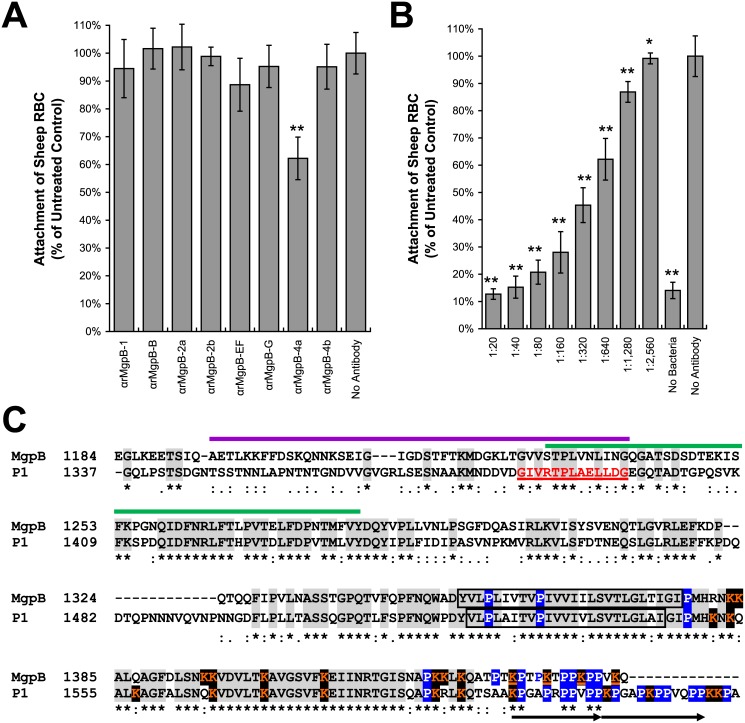
Attachment domains within MgpB are Located within the Proximal Conserved C-terminus and Share Homology with the Attachment Domain of the M. pneumoniae P1 Protein.(A) The results of the quantitative hemadsorption inhibition assay showing that antibodies reacting with the proximal conserved C-terminus (α-rMgpB-4a) diluted 1:640 inhibit hemadsorption by approximately 40% (**, p < 0.0001). At dilutions with comparable reactivity to MgpB (1:20, α-rMgpB-2b and-EF; 1:40, α-rMgpB-2a and-G; 1:80, α-rMgpB-1 and -4b; 1:320 α-rMgpB-B), antibodies reacting with other regions of MgpB have no statistical impact on the binding of red blood cells with results similar to untreated control wells not pretreated with antibodies. (B) Hemadsorption inhibition experiments demonstrating the inhibitory effect of α-rMgpB-4a antibodies was dose dependent; two-fold dilutions of this antibody ranging between 1:20 and 1:1,280 significantly decrease hemadsorption (**, p < 0.0001; *, p = 0.007) with lower dilutions completely inhibiting the binding of red blood cells with results comparable to the no bacteria control wells. In panels A and C, error bars represent standard deviation. (C) Alignment of the proximal and distal conserved C-termini of MgpB (aa 1,184–1,444) with the C-terminus of the homologous P1 adhesin (aa 1,337–1,627) of M. pneumoniae, for which the attachment domain has also been defined. Within P1, the location of peptides 7 and 8 [48] are noted with purple and green lines, respectively, and the binding epitope for the attachment inhibiting monoclonal antibody [49] (designated PepD) is underlined in red. Amino acids identically conserved between MgpB and P1 are highlighted in gray; additionally, predicted transmembrane domains predicted by TMHMM are boxed and the location of cytoplasmic proline (white/blue) and lysine (orange/black) residues are indicated. The arrows beneath the P1 sequence at the distal conserved C-termini note the location of a simple tandem repeat of unknown significance.